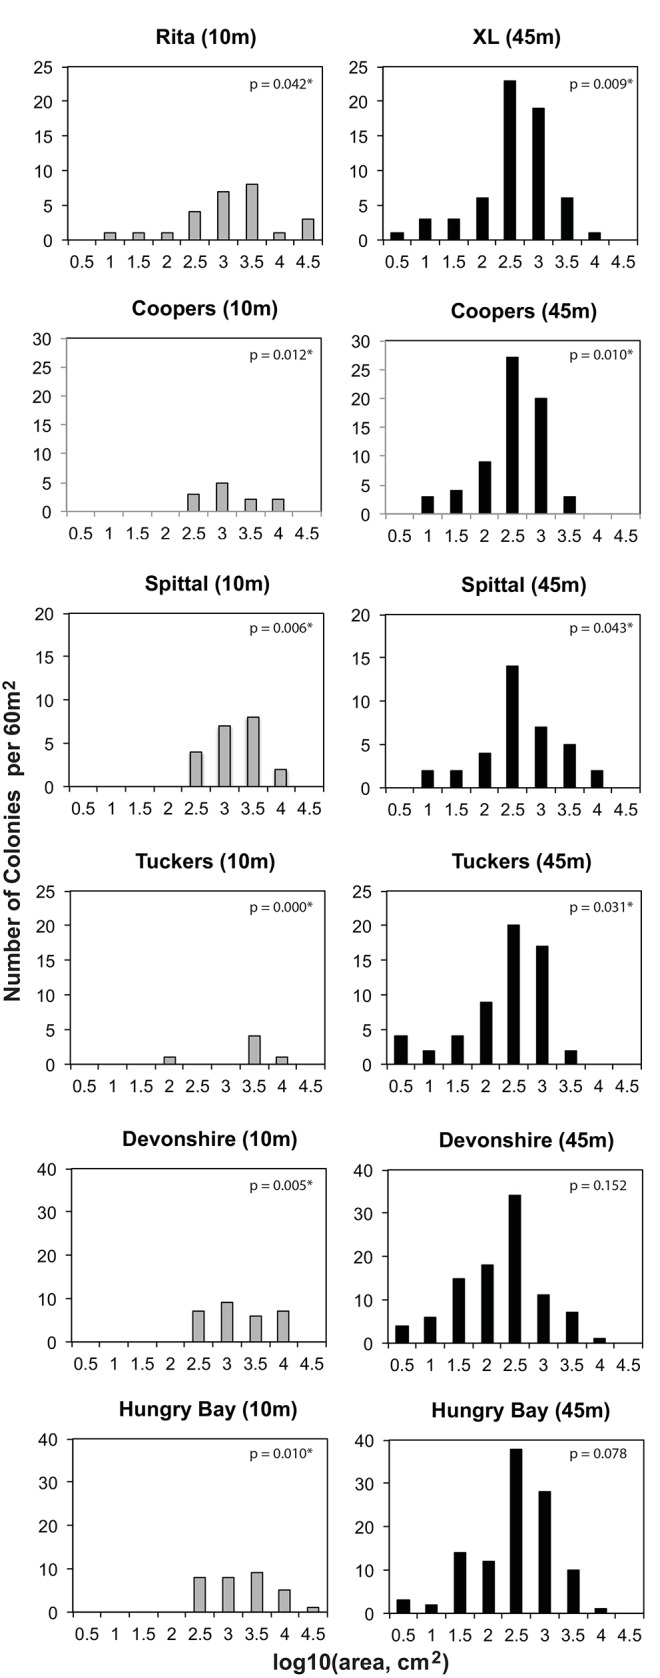
Size-Frequency by Site.Size-frequency distributions of M. cavernosa on a logarithmic scale represented as the number of individuals within each log transformed size class for colonies from each survey location (Rita/XL, Coopers, Tuckers, Spittal, Devonshire, Hungry Bay) at 10m (gray bars) and 45m (black bars) depths. Sites that differed significantly from a normal distribution are indicated with an asterisk (*; α<0.05).